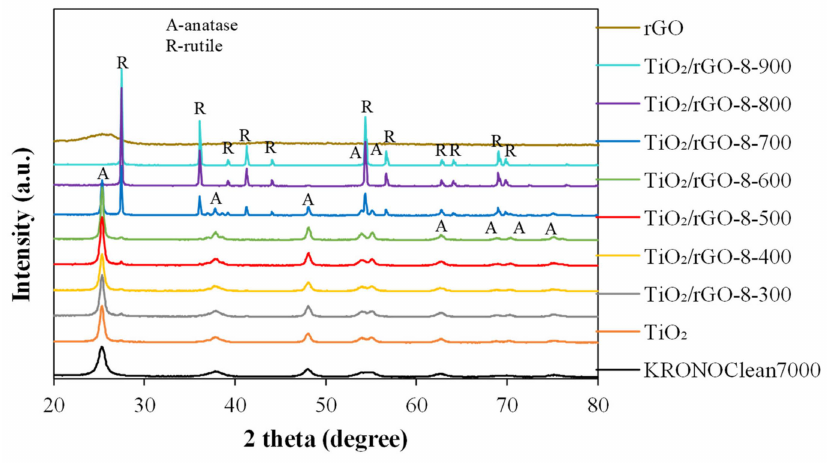
Figure 2. XRD patterns of reference, control, and obtained